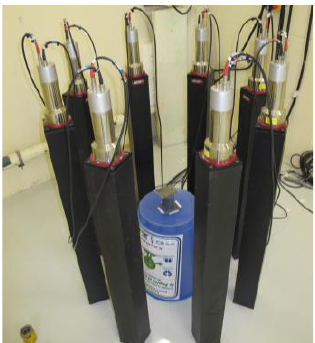
Fig. 1. Experimental set-up: 8 EJ-200 scintillators surrounding the 252 Cf source placed on a 50 cm height support.